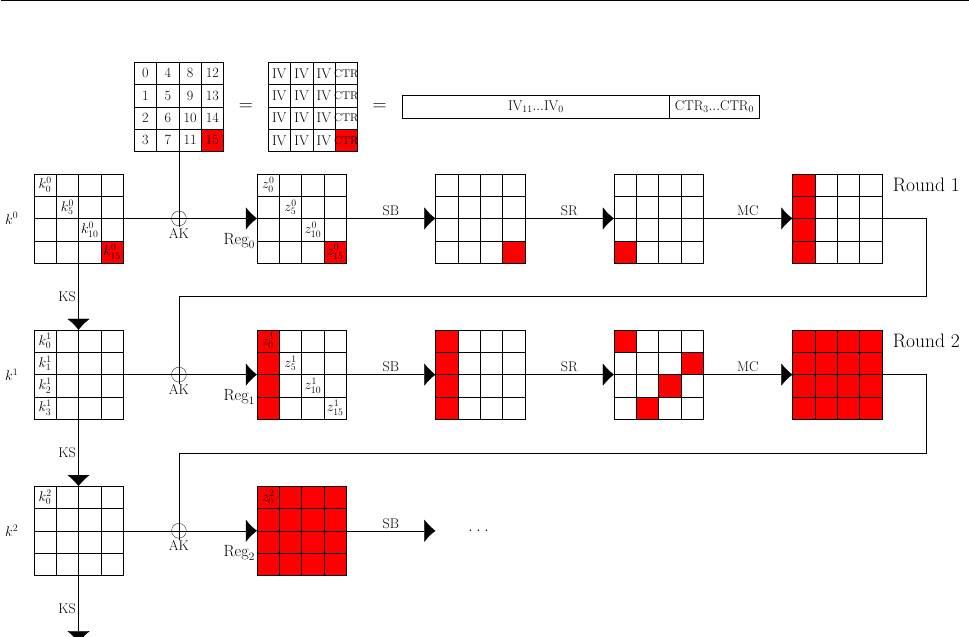
Figure 4: Sketch of AES-ECB with plaintext as used in this AES-GCM implementation. Each round ends with the state register Reg , i.e., Round 1 ends after adding subkey k 1 and i storing the result in Reg . The changes when only CTR increases every encryption are 1 0 highlighted in red. Abbreviations used: AK = Add Round Key, SB = S-Box (Substitution Box), SR = Shift Row, MC = Mix